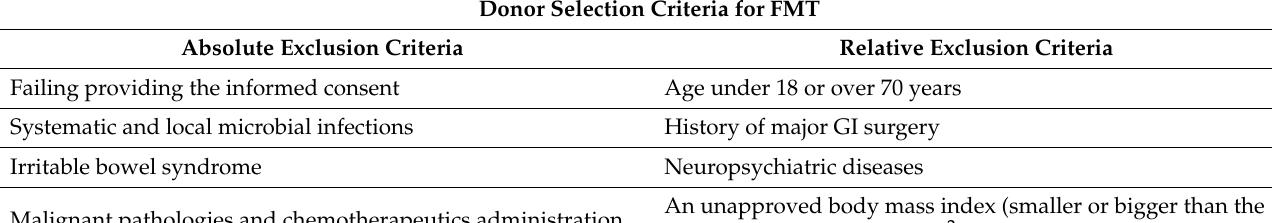
Table 1. Donor selection criteria for FMT. Donor Selection Criteria for